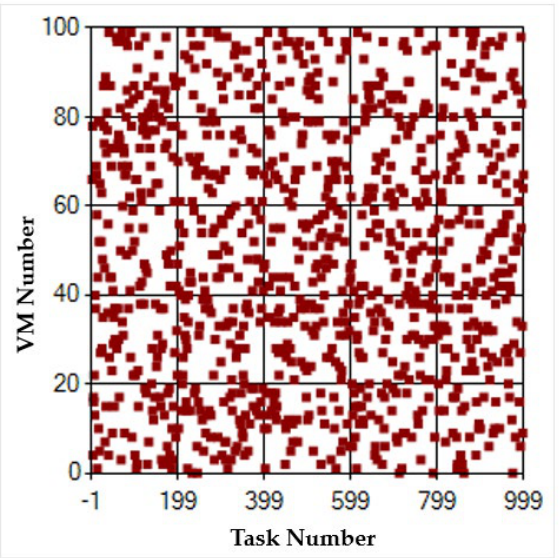
Figure 9. Assignment of tasks to virtual machines after executing the CGM method on the developed simulator (for experiment 4). Table 6. Results of several runs of all optimization algorithms on a single configuration for the BoT scheduling